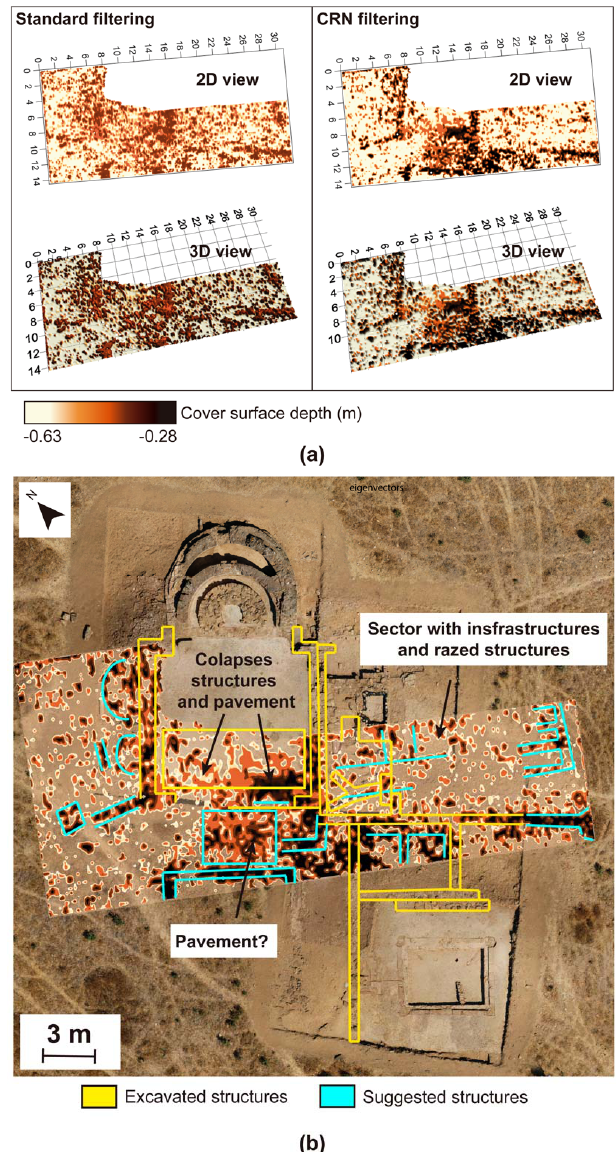
Figure 11. ( a ) Cover surfaces from Standard and CRNF datasets (2D and 3D views). ( b ) Cover surface from CRNF dataset superimposed on an aerial image obtained by a drone (provided by Geodrone). A schematic representation of the visible structures (yellow lines) and the alignments obtained by the geophysical prospection (blue lines, unexcavated) is included. The CRNF results show that the structures visible in the Standard dataset become more defined and better